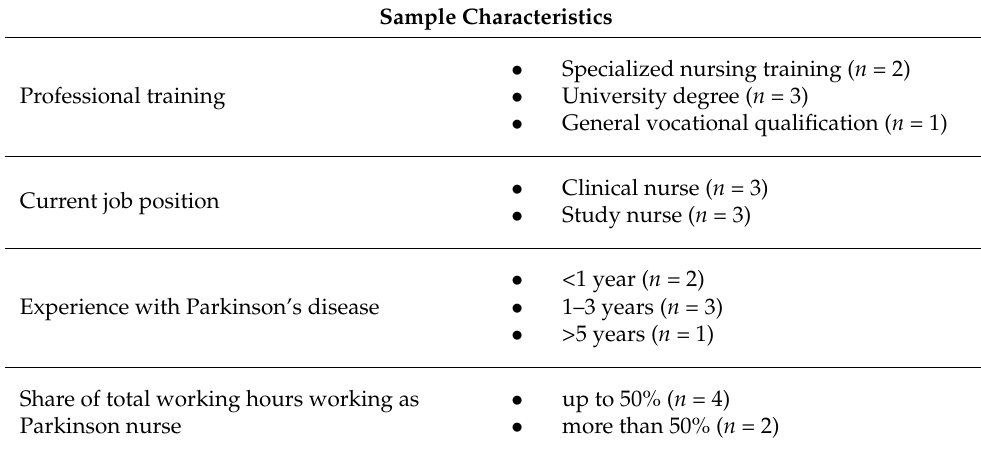
Table 2. Sample description.